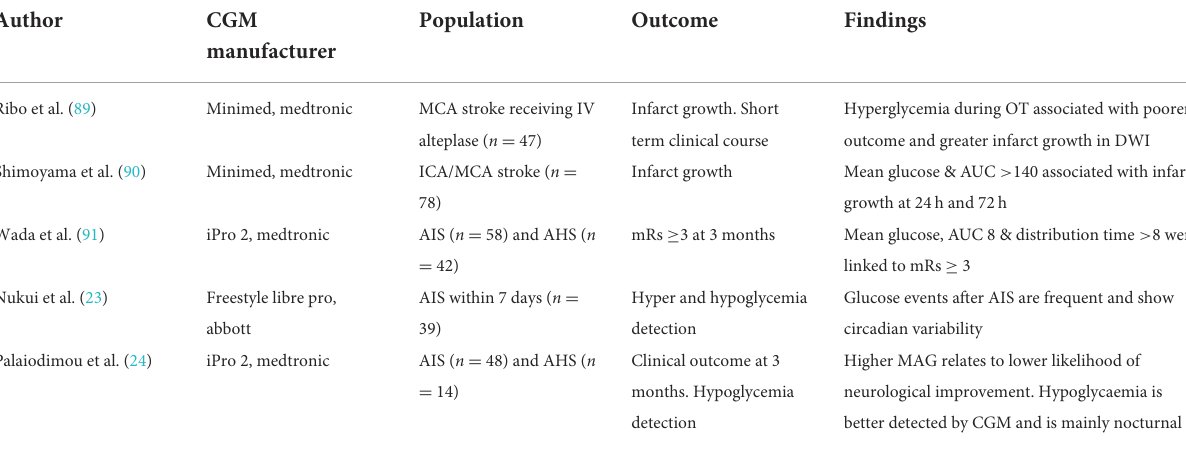
TABLE 2 Studies assessing potential clinical impact of CGM in cerebrovascular acute disease